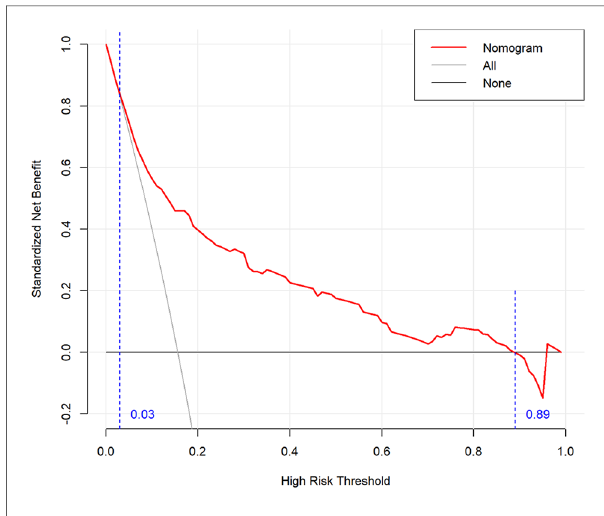
FIGURE 5 Decision analysis curve of a nomogram predicting